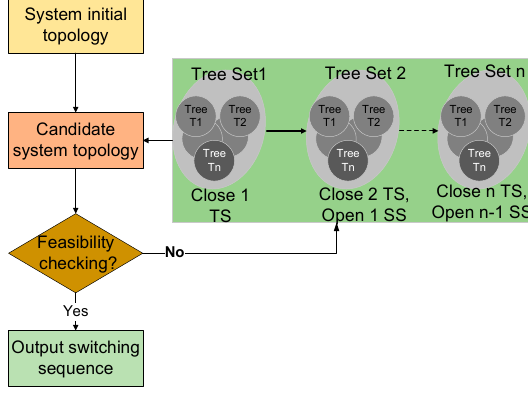
Figure 5. Flowchart of the spanning tree search algorithm.